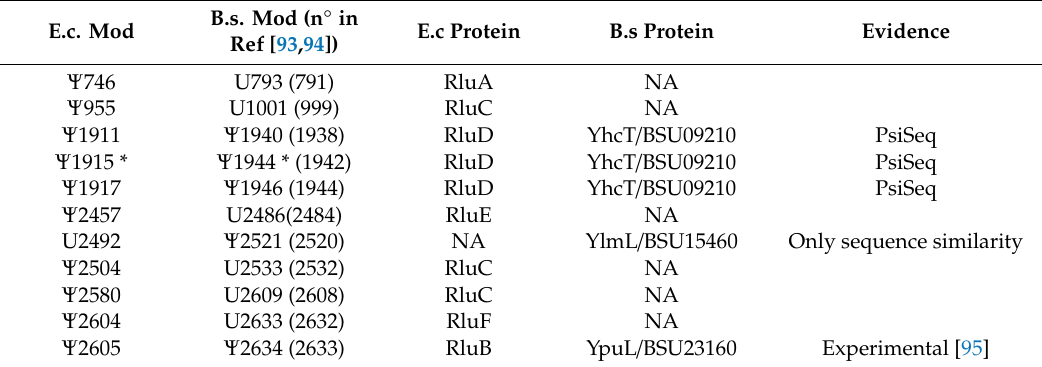
Figure 4. Analysis of pseudouridine residues in tRNAs and rRNAs by PsiSeq. Normalized PsiSeq signals are shown for selected regions in B. subtilis tRNAs and 23S rRNA. The top row corresponds to the wild ‐ type strain, the middle one for the Δ yjbO mutant, and the bottom one for the Δ yhcT mutant. Positions of known and detected pseudouridine residues are shown by red arrows. Conventional numbering of tRNA positions may not correspond to real position of nucleotide in the sequence due to missing residues and inclusion of 17a, 20a, 20b, and variable loop nucleotides. Identity of tRNA and its anticodon are indicated on the top of each panel. YjbO is involved in pseudouridylation of position 31 (and also 32) in several tRNAs. YhcT is involved in pseudouridylation of 23S rRNA positions 1940, 1944, and 1946 and is the functional equivalent of E. coli RluD. Table 2. Comparison of ψ sites and corresponding modification enzymes in 23S rRNA of E. coli and B. subtilis